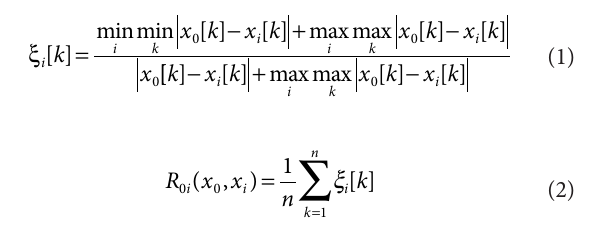
Frontiers in Plant Science |